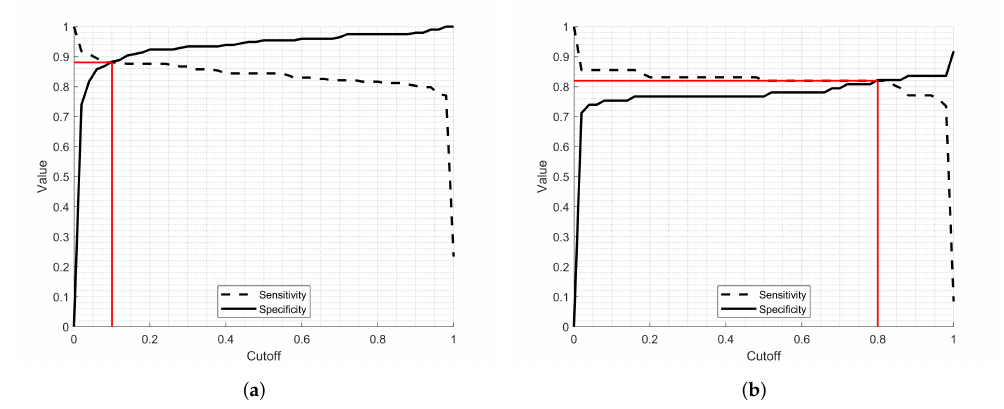
Figure 9. Sensitivity-specificity plot of ( a ) the ItalianPVS dataset and ( b ) the Lithuanian voice dataset. The time performance of the proposed deep learning model on both datasets is com- pared in Figure 10. An excellent time performance of processing one voice record in just 4 ms was demonstrated, which experimentally validated the characteristics presented in Table 2. The results show that the proposed model can be used for real-time PD screening.